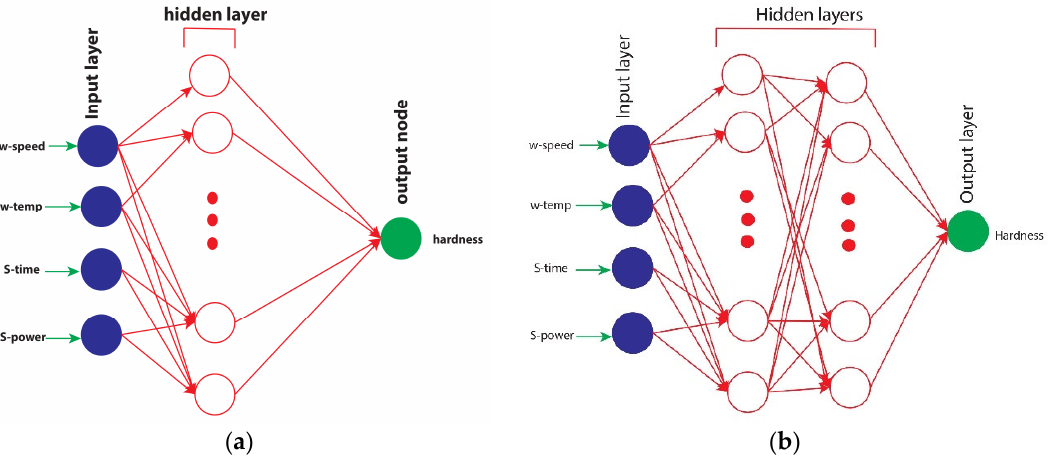
Figure 7. ( a ) and ( b ), graphical representation of a neural network.